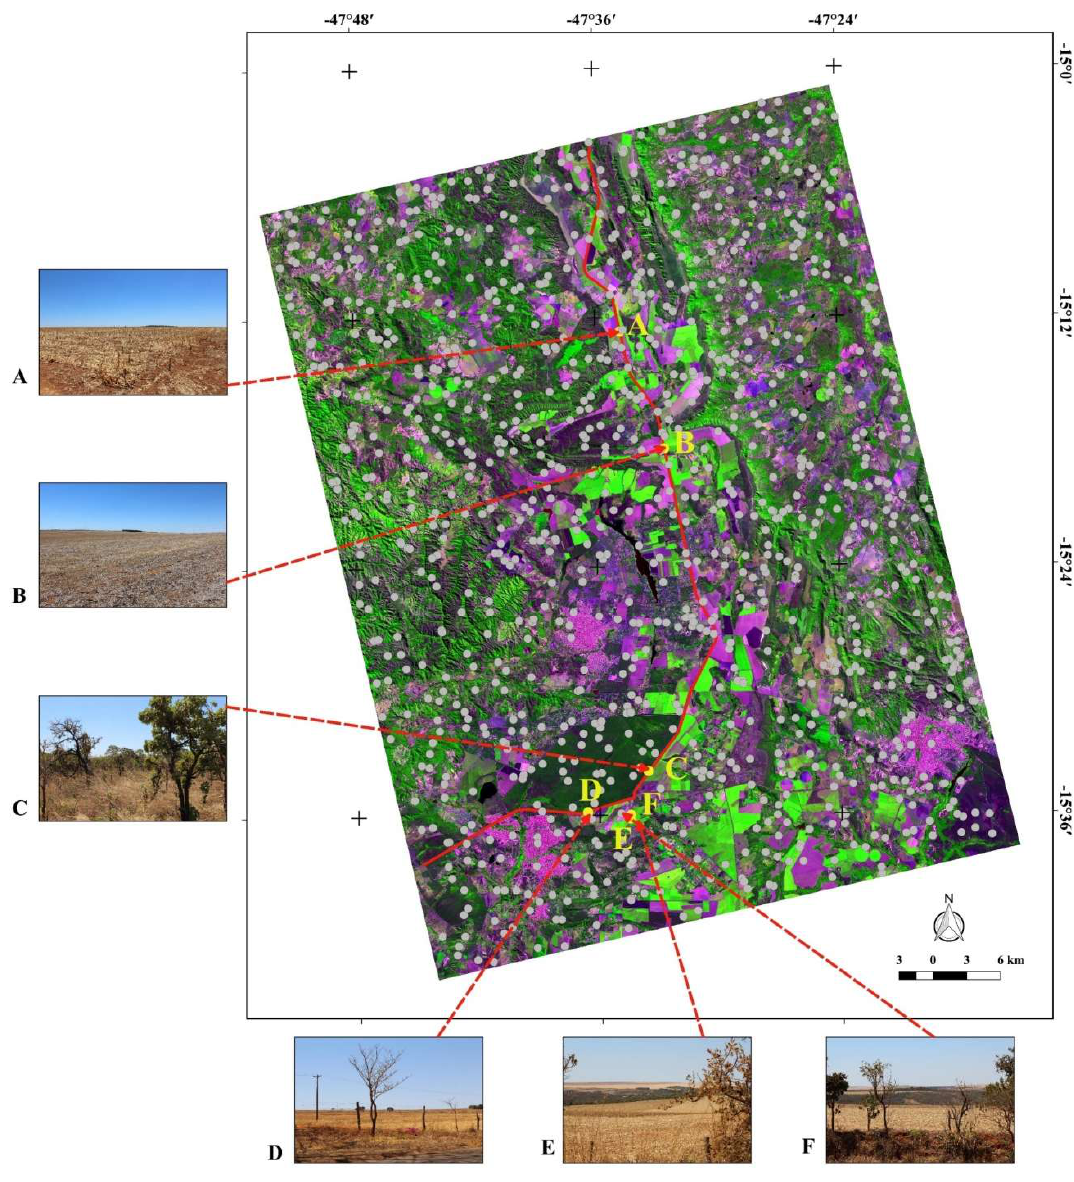
Figure 3. Location of the sampling points for validation of the ALOS-2 / PALSAR-2 image segmentation and classification. The panoramic field photos were obtained by the first author in September of 2017 ( A , B , and D = harvested corn (bare soil / straws); C = shrub Cerrado; E and F = harvested corn with forestland in the back). The image corresponds to the RGB color composite of the LANDSAT-8 / Operational Land Imager (OLI) satellite (bands 4, 5, and 3).